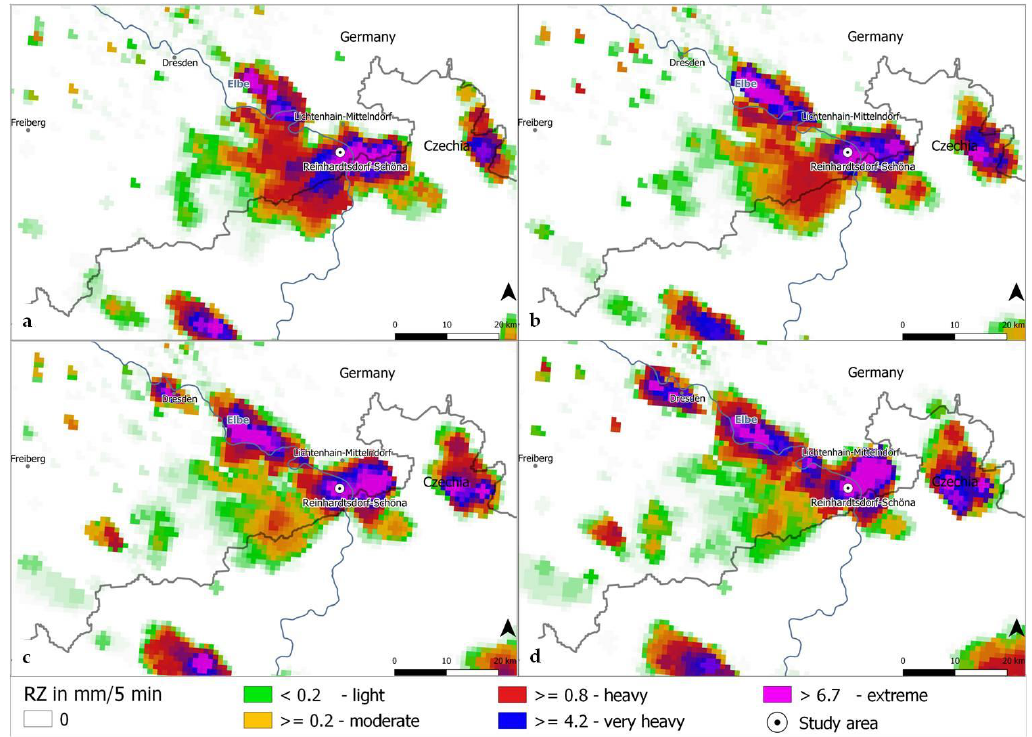
Figure 6. The selected storm event in 5-min time steps on 31 May 2016 from ( a ) 2:20 p.m., ( b ) 2:25 p.m., ( c ) 2:30 p.m. to ( d ) 2:35 p.m.